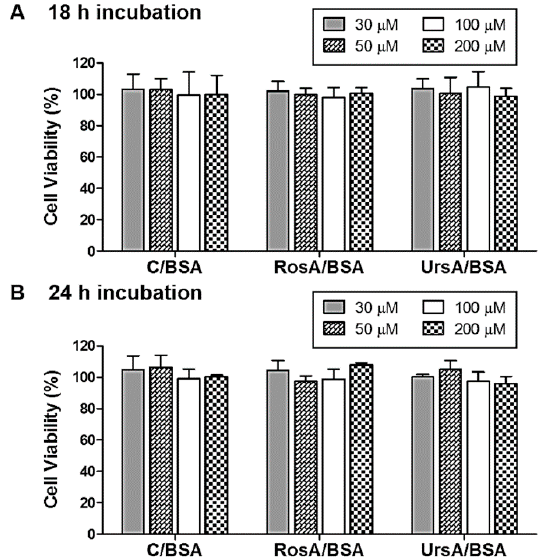
Figure 6. Cytotoxicity tests of adult retinal pigmented epithelial (ARPE) cells. A WST1 assay was used to evaluate cell viability percentages for the treated cells with drug/BSA particles (C/BSA, RosA-BSA, and UrsA-BSA) in various drug concentration ranges (30–200 µM). Percentages compared to the untreated control cells are shown in the bar plots for each group of cells treated with different types of drug/BSA formulations after ( A ) 18 h or ( B ) 24 h incubation.